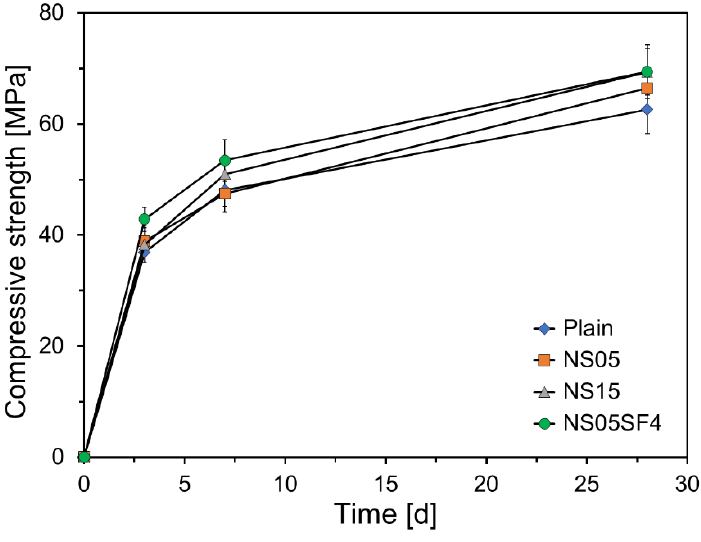
Figure 8. Compressive strengths of